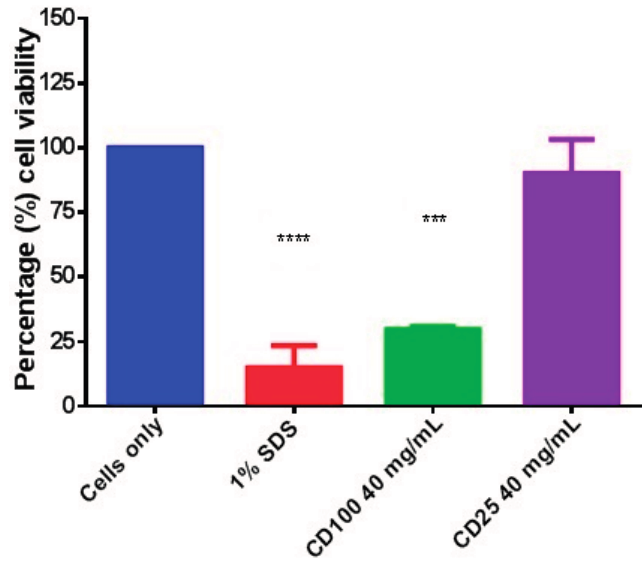
Figure 3. In vitro cytotoxicity evaluations of CD-100 and CD-25 hydrogel at 40 mg·mL − 1 . Cells only serve as a negative control and 1% sodium dodecyl sulfate (SDS) served as the cytotoxic positive control. Data are presented as mean ± SD performed using one-way analysis of variance (ANOVA) followed by a Bonferroni’s multiple comparison. ( *** p < 0.001), ( **** p < 0.0001) as compared to cells only